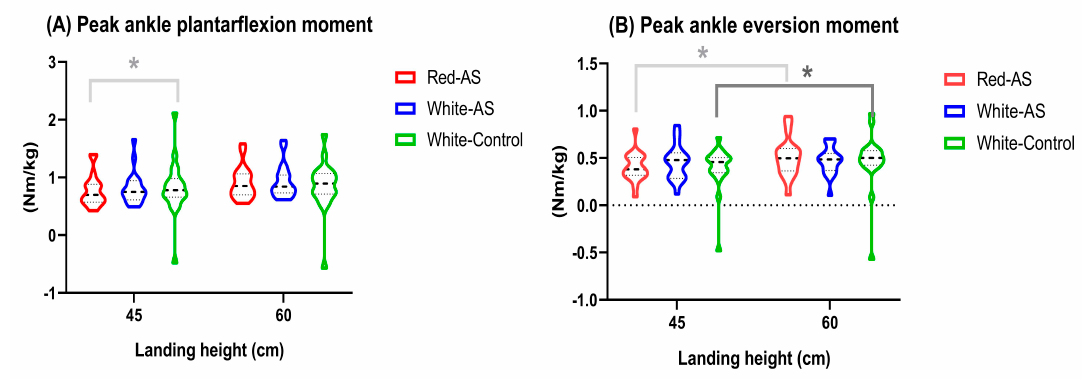
Figure 3. ( A ) Peak ankle plantarflexion moment and ( B ) peak ankle eversion moment by landing height and insole